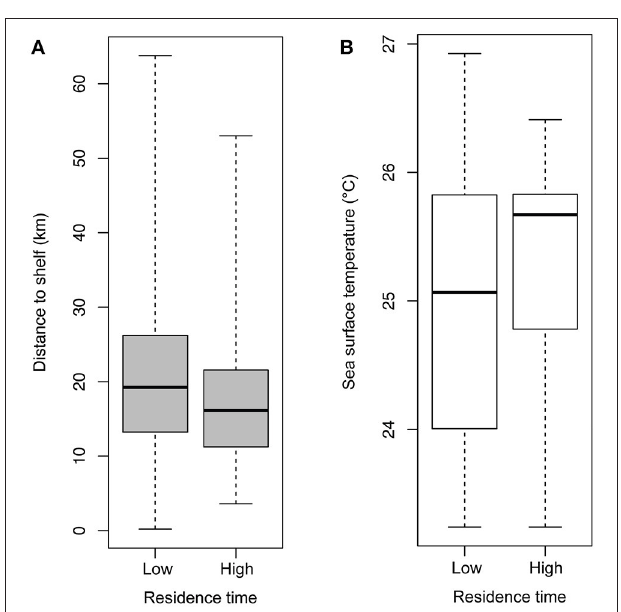
FIGURE 5 | Box plots of (A) distance (km) to the 100m shelf break for locations where birds had low- and high-residence time and (B) sea surface temperature ( ◦ C) for locations where birds had low- and high-residence time. Differences between both groups were significant, and data shown are